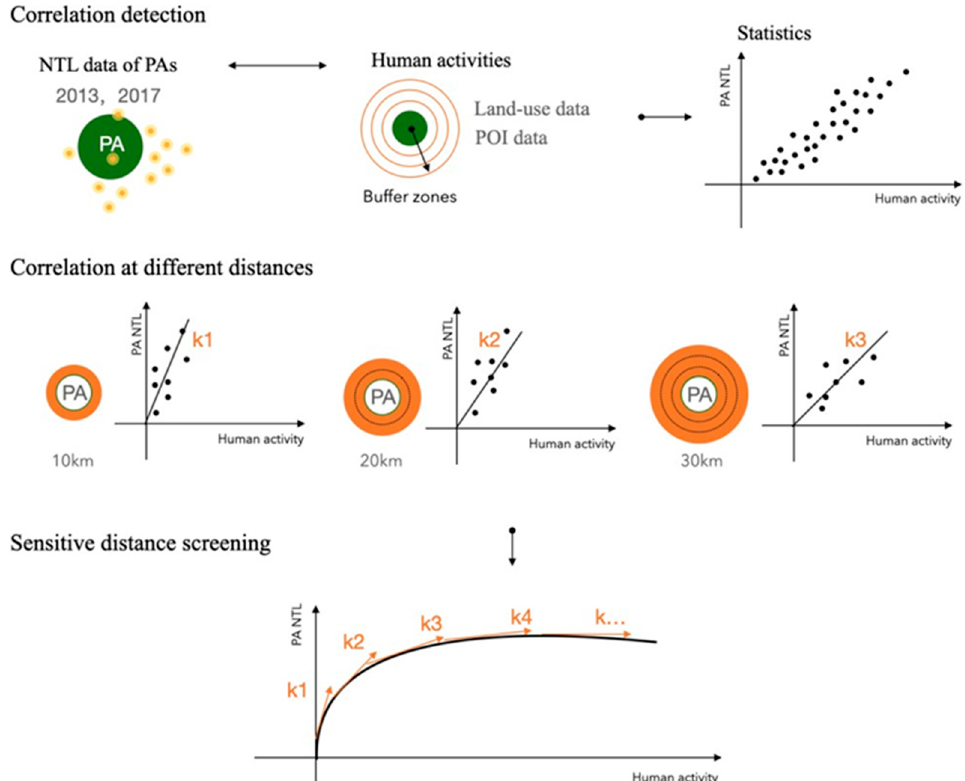
Figure 2. Research methods diagram.